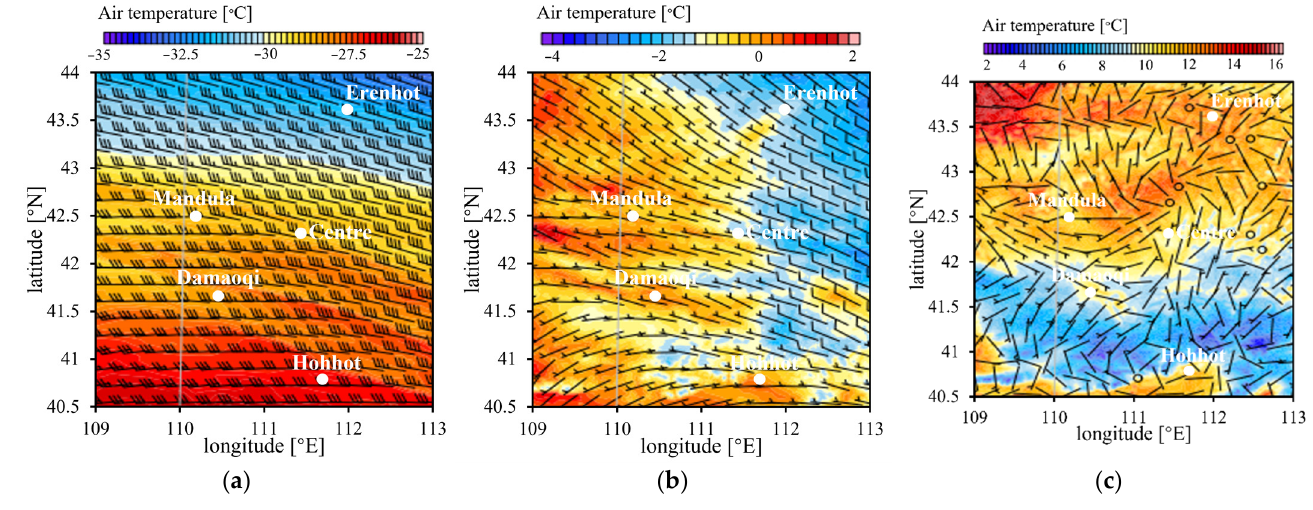
Figure 5. Stratified wind vector maps at altitudes of about ( a ) 6700 m, ( b ) 2000 m and ( c ) 15 m, respectively.